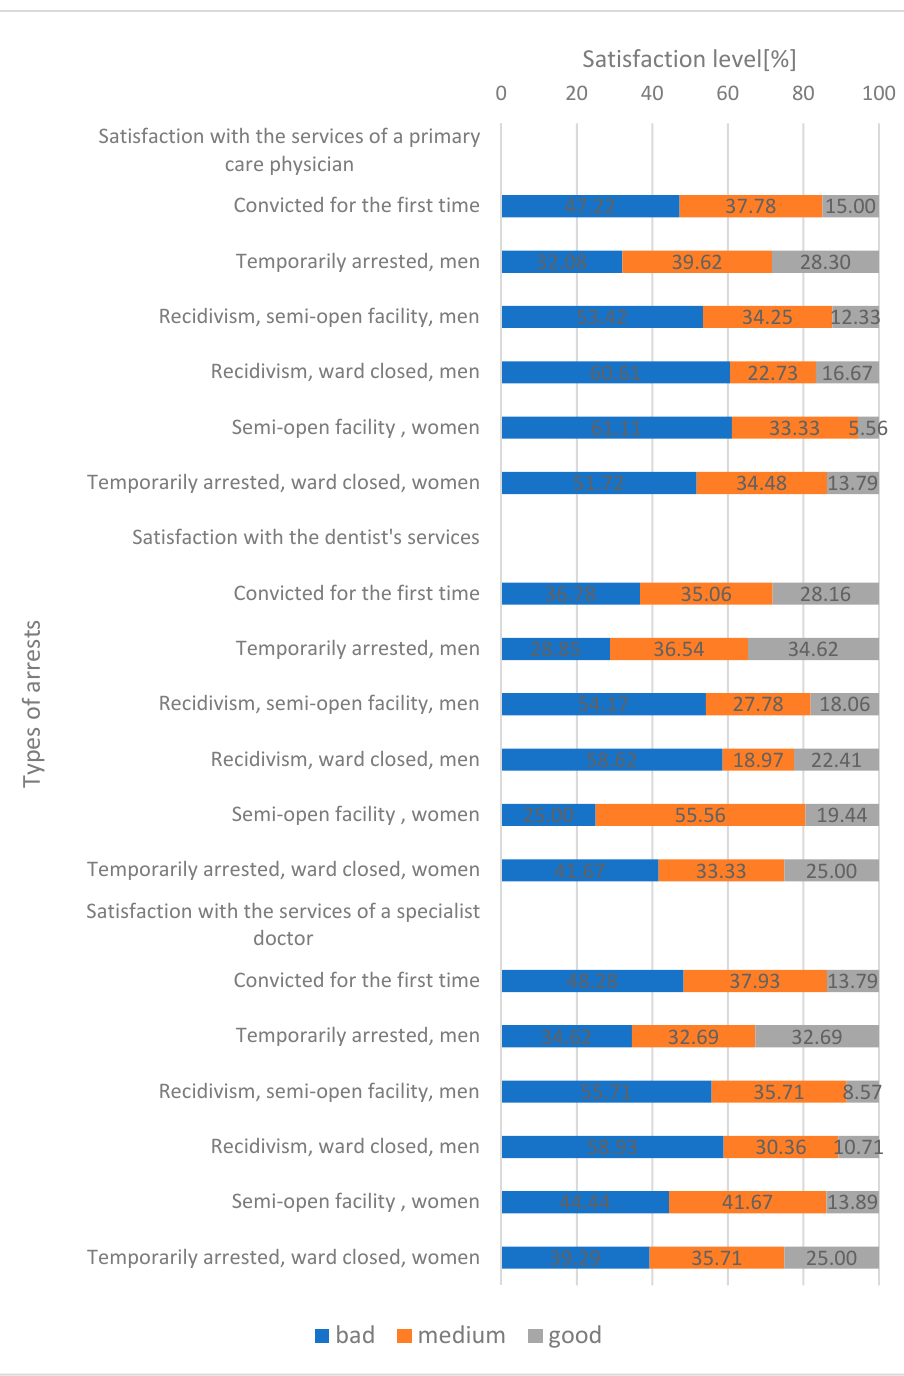
Figure 2. Satisfaction with the health services (“bad”, “medium”, “good”) (test Chi-square).